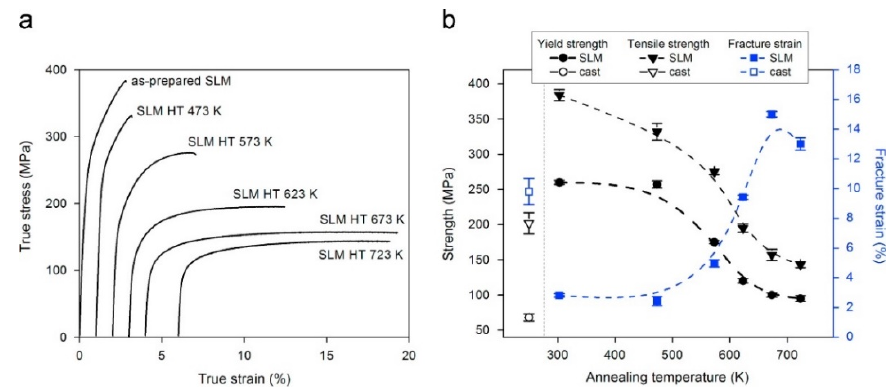
Figure 60. ( a ) Room temperature tensile test curves of SLM Al-12Si samples (γ = 90°) annealed at different temperatures and ( b ) corresponding mechanical data [67]. Copyright 2013. Adapted with permission from Elsevier Science Ltd. under the license number 4803760682810 (Figure 6 [67]), dated